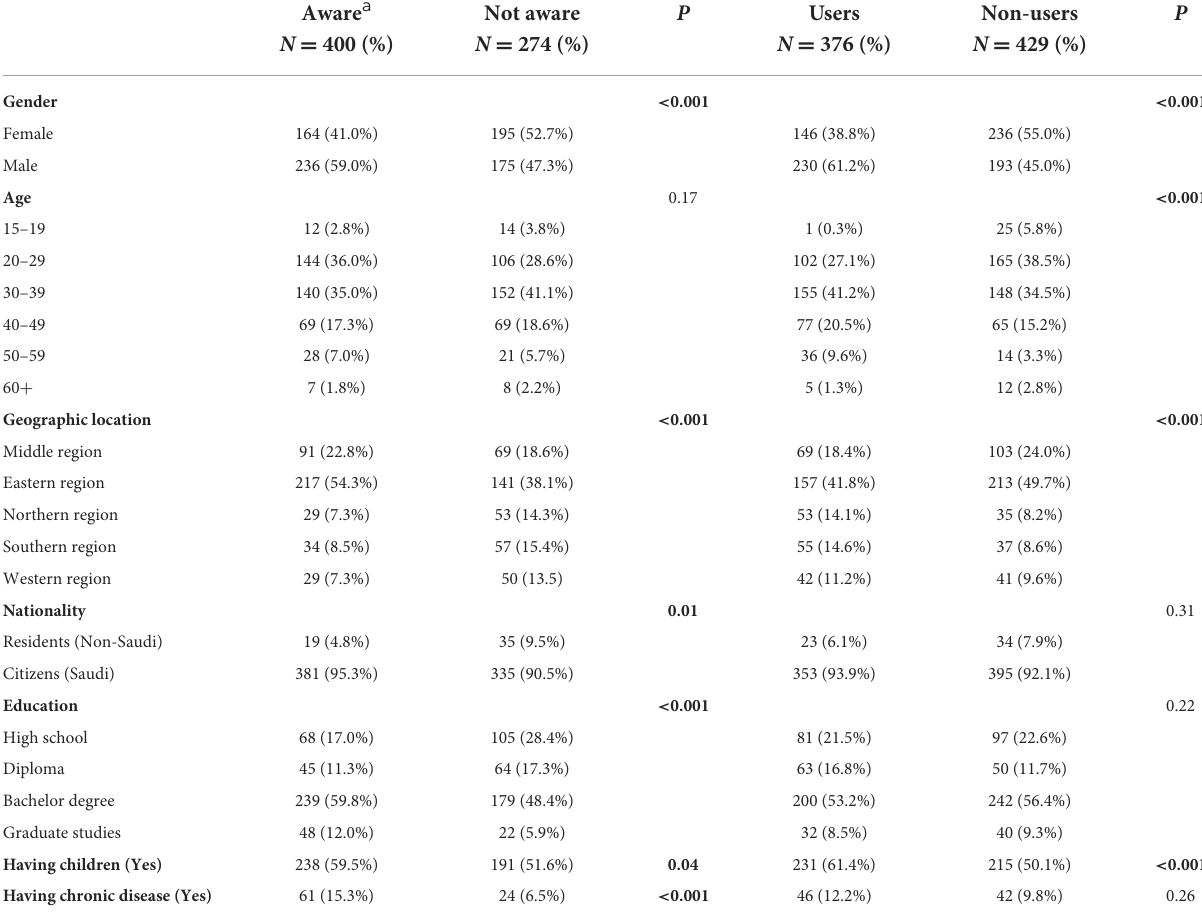
TABLE 3 Bivariate analysis of awareness and use of 997 EMS phone